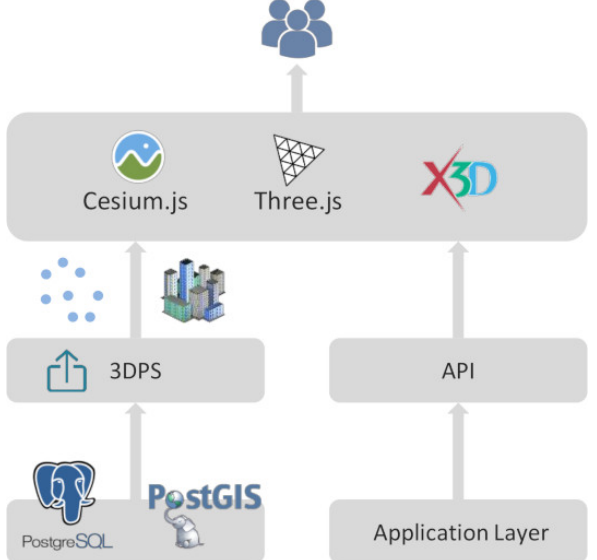
Figure 4. A prototype web client for identifying high wind energy potential locations using the Three.js runtime